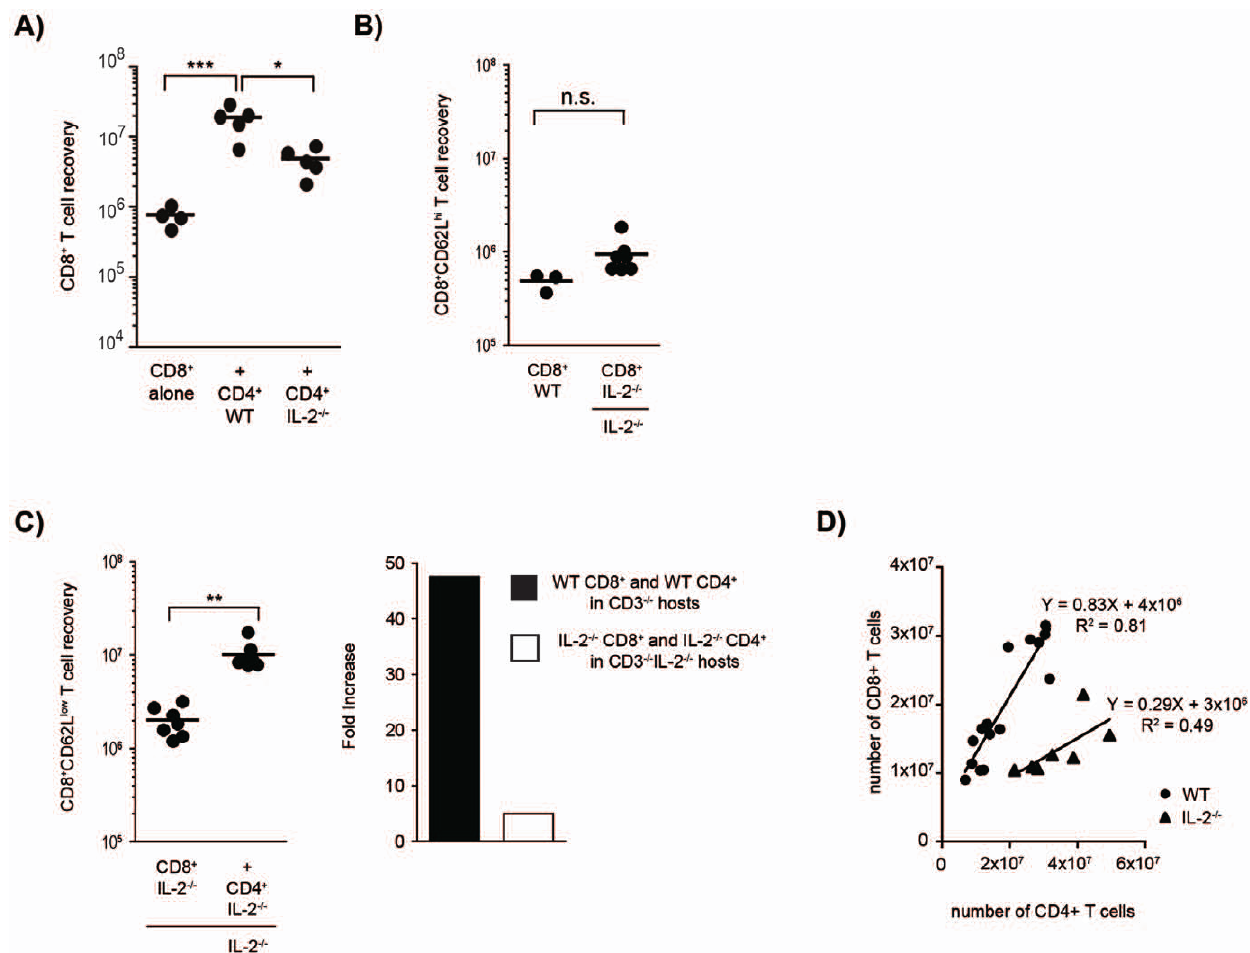
Figure 6. Role of IL-2 in the CD4 + -dependent accumulation of CD8 + T cells. ( A ) 1.5 6 10 4 CD8 + T cells from WT mice were transferred alone or with equal numbers of CD4 naive T cells from WT or IL-2-deficient mice into CD3 e 2 / 2 hosts. CD8 + T cell recovery in individual hosts of the 3 groups is shown. ( B ) 2 6 10 4 CD8 + T cells from IL-2-deficient mice were transferred alone or with CD4 T cells into immune-deficient WT or IL-2 2 / 2 hosts. The CD8 + CD62L high T CM cell recovery after 7 weeks is shown for two pooled experiments. ( C ) The left panel shows the CD8 + CD62L low T EM cell recovery after 7 weeks in IL-2 2 / 2 hosts from two pooled experiments. The right panel shows the fold increases of CD8 + T EM cell recovery calculated by dividing the number of CD8 + T cells recovered in the presence of CD4 + T cells by the number of CD8 + T cells recovered in the absence of CD4 + T cells. CD8 + CD62L low T cell recovery increased about 50-fold, under WT conditions, but only 5-fold in the absence of IL-2. (** p # 0.01). WT data pooled from 3 different experiments ( D ) Correlation of the number CD8 + T cells and CD4 + T cells recovered in individual hosts in the presence or in the absence of IL-2. The correlation coefficients are shown (p , 0.0001 and p , 0.03 respectively). Data pooled from 3 different